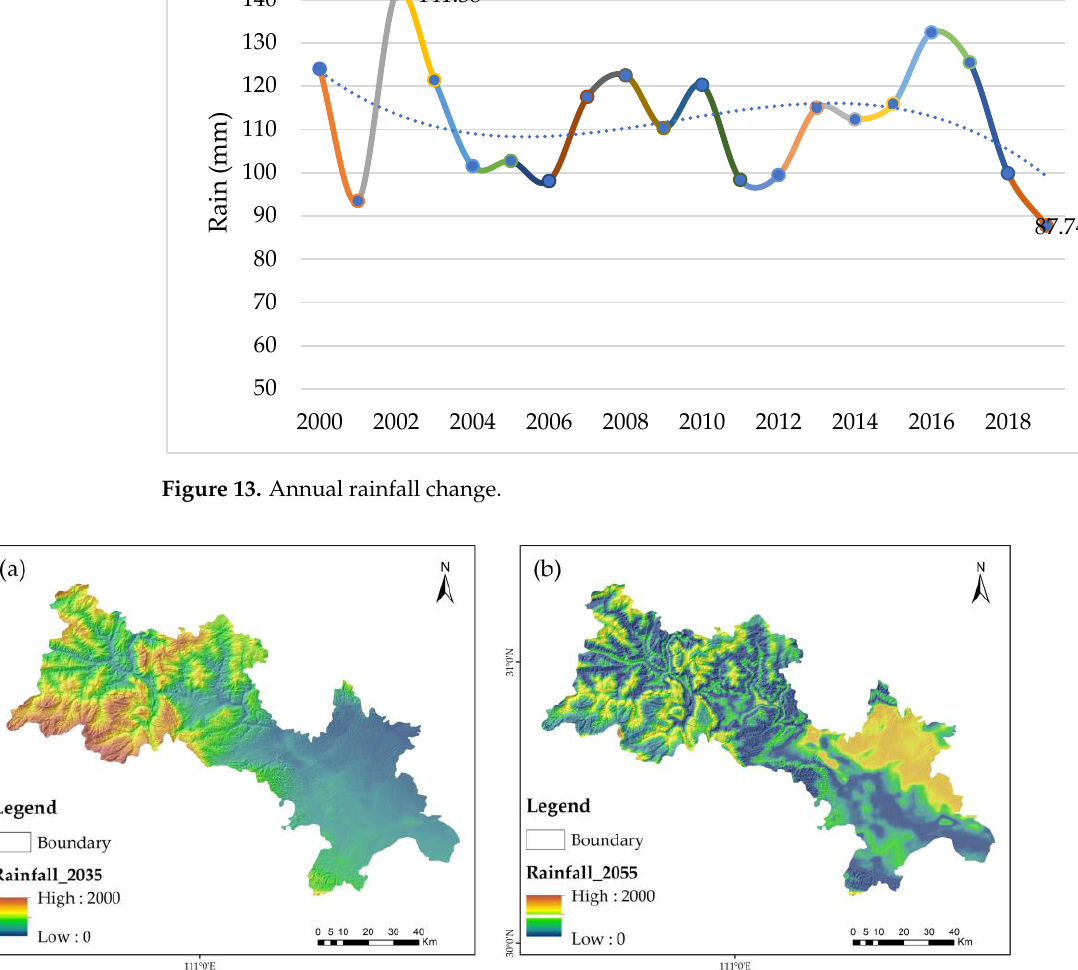
Figure 14. Rainfall Forecast Results. ( a ) Annual rainfall predication for 2035; ( b ) Annual rainfall predication for 2055.